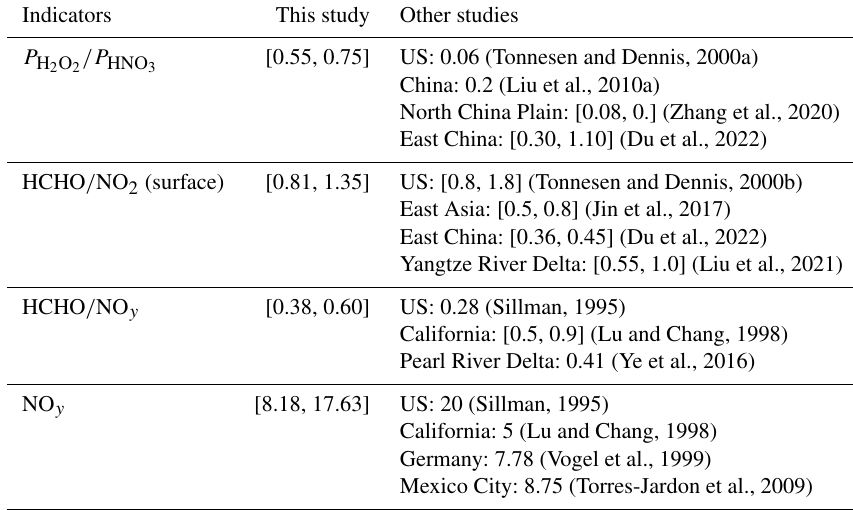
Figure 3. Relationships between the simulated O 3 reductions with the perturbed emissions and concurrent values of P H HCHO / NO 2 , HCHO / NO y , and NO y at all the grid cells in the domain. The red (blue) lines represent the average O 3 changes resulting from VOC (NO x ) emission reductions, with the shaded areas for the standard deviations. The thresholds derived in this study (see Table 3, with the method detailed in Sect. 2.3) are indicated by the gray vertical lines. Table 3. Thresholds of the indicators derived in this study and reported in previous